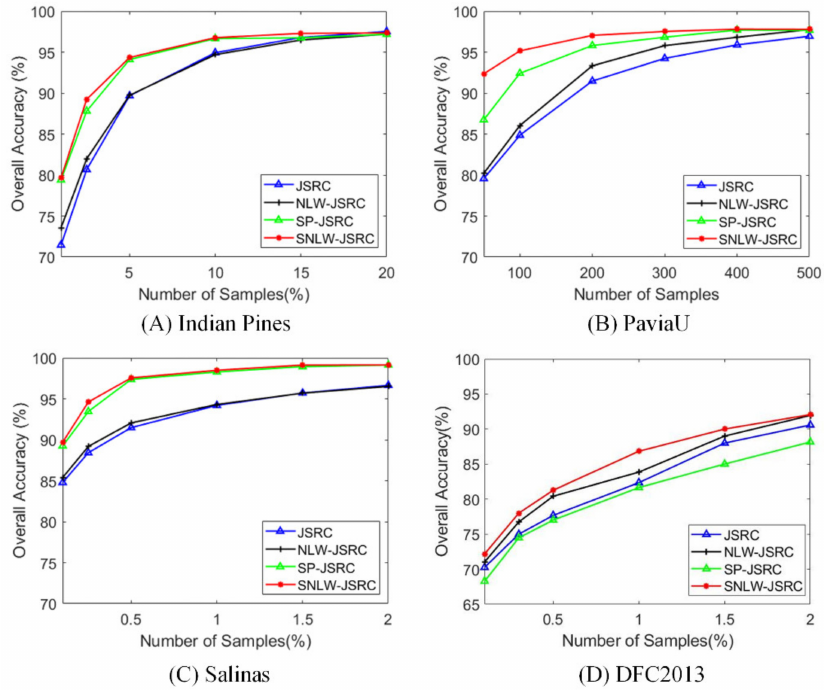
Figure 9. Effects of the number of training samples; ( A – D ) are based on Indian Pines, PaviaU, Salinas, and DFC2013 images,